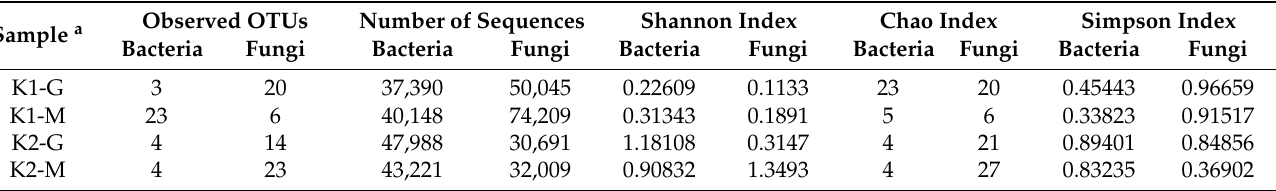
Table 1. Sequencing results for the two Tibetan kefir grains and two related kefir milks.